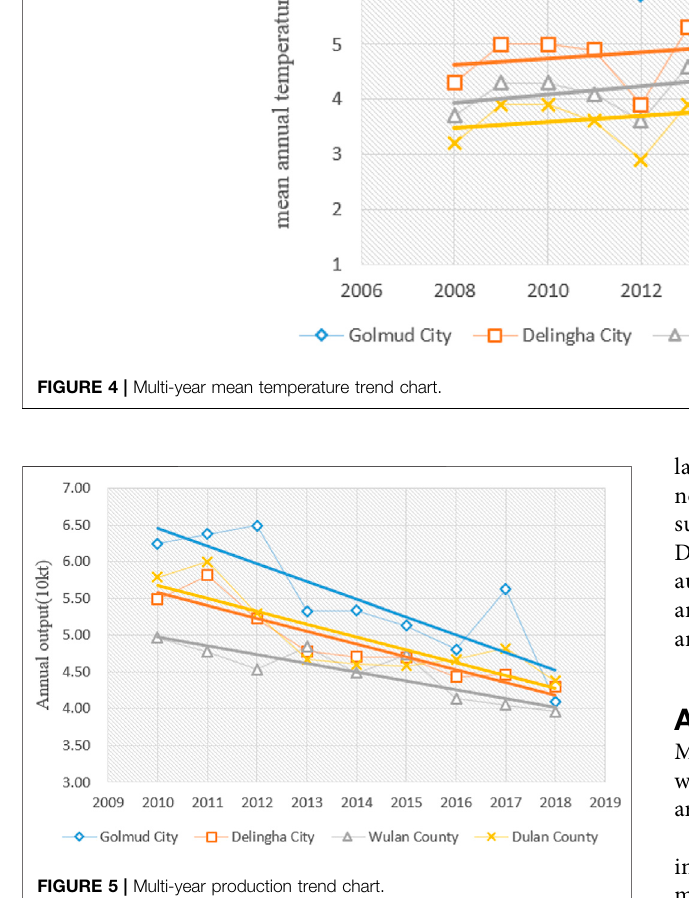
FIGURE 5 | Multi-year production trend